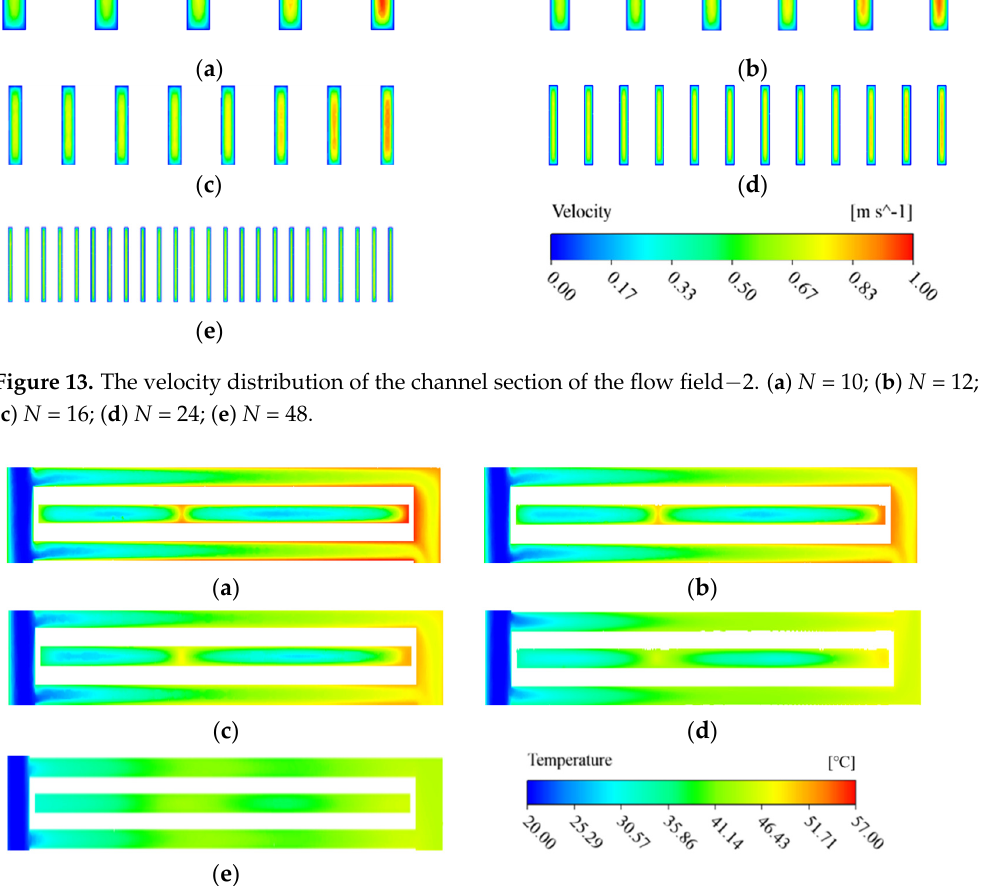
Figure 13. The velocity distribution of the channel section of the flow field − 2. ( a ) N = 10; ( b ) N = 12; ( c ) N = 16; ( d ) N = 24; ( e ) N = 48.